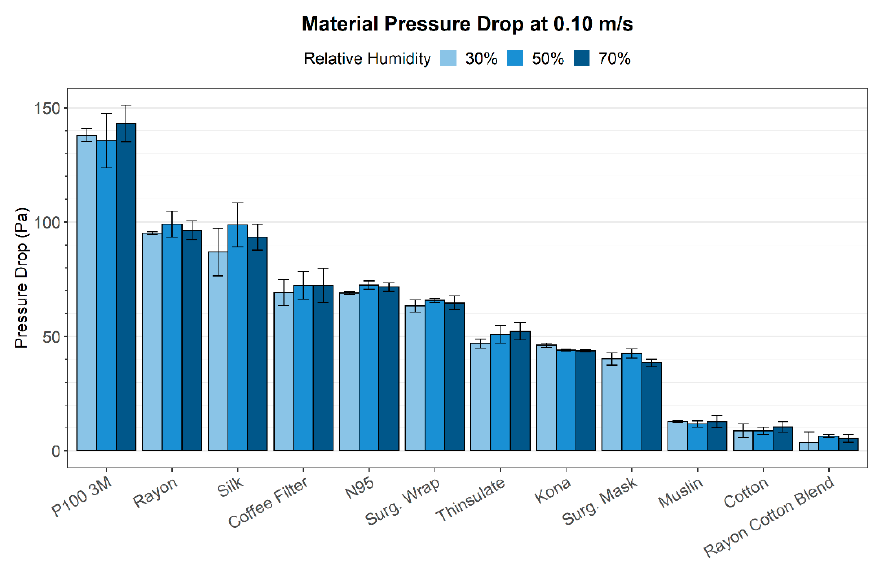
Figure 4. Pressure drop for single-layered materials as a function of RH. Bar colors represent the corresponding RH value, and results are plotted as the average pressure drop from three runs, with the error bars representing the standard deviation.